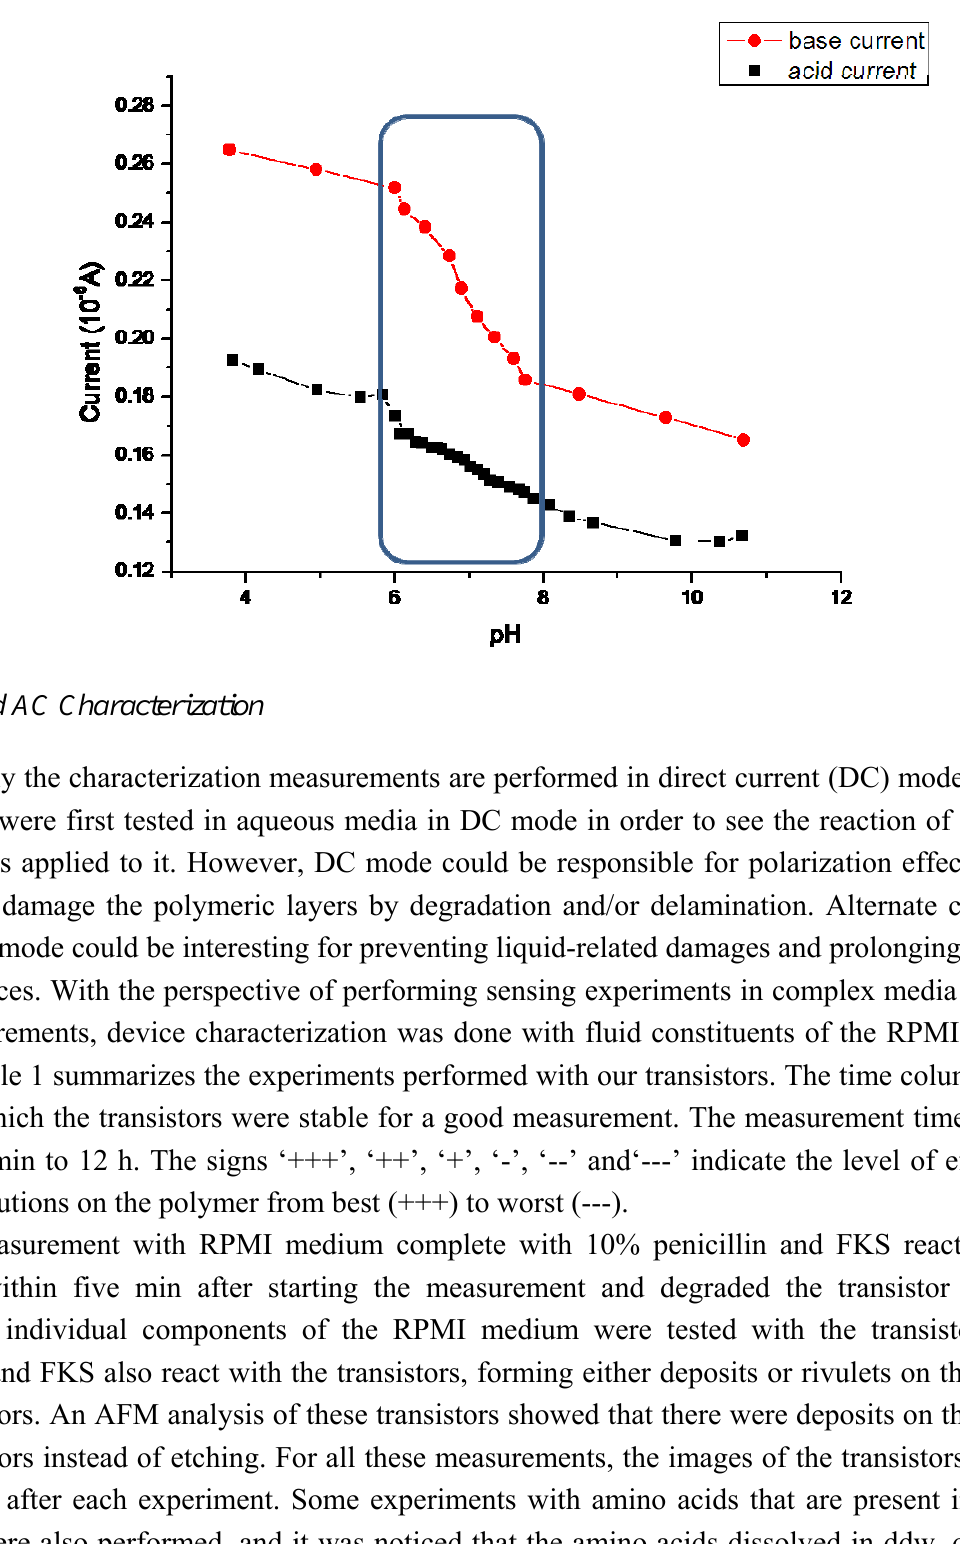
Figure 3. Transistor current behavior under various pH conditions. The transistor current was measured in DC mode with the drain-source voltage at 1 V and open gate. The enclosed area in the figure depicts the linear working range of the transistors from pH 6 to pH